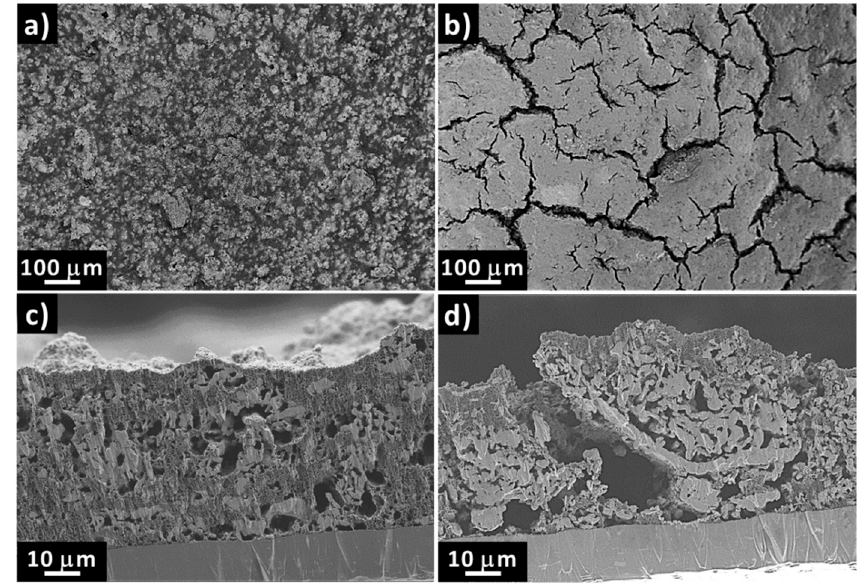
Figure 3. SEM pictures of the ( a ) surface of NaMFC_PVDF, ( b ) surface of NaMFC_CMC, ( c ) cross-section NaMFC_PVDF and ( d ) cross-section NaMFC_CMC. PVDF = polyvinylidene fluoride. CMC = carboxymethylcellulose.